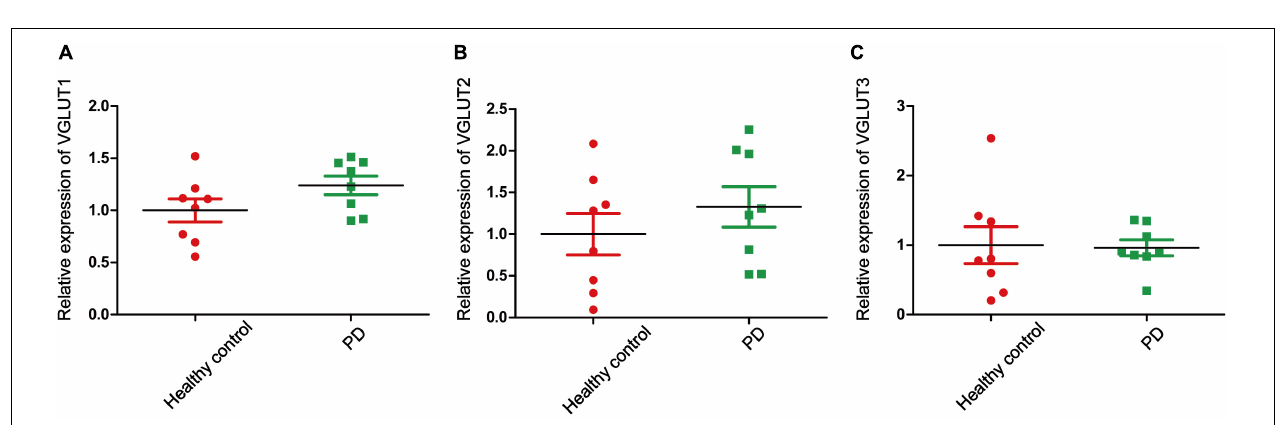
FIGURE 4 | The relative expression of VGLUTs. (A) The relative expression of VGLUT1 in PD patients and healthy controls. (B) The relative expression of VGLUT2 in PD patients and healthy controls. (C) The relative expression of VGLUT3 in PD patients and healthy controls. Each bar represents the mean ± SE ( n = 8).